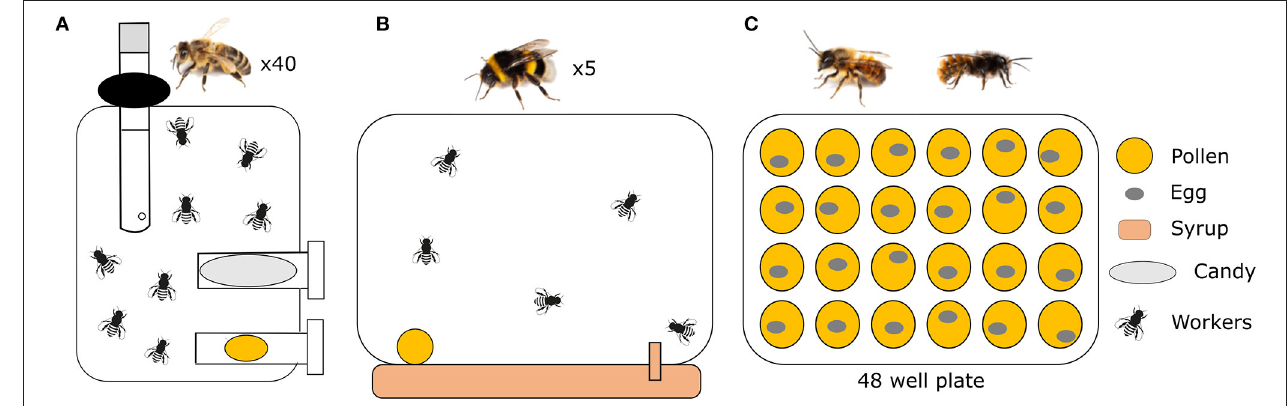
FIGURE 1 | Experimental set-ups for (A) honeybees, (B) bumblebees and (C) mason bees. Caged honeybees were provided with water, candy, and one of the pollen diets. Five bumblebees (workers) were placed in plastic boxes provided with pollen and syrup. Eggs of mason bees developed in cell culture plates of 48 wells filled with 400mg of